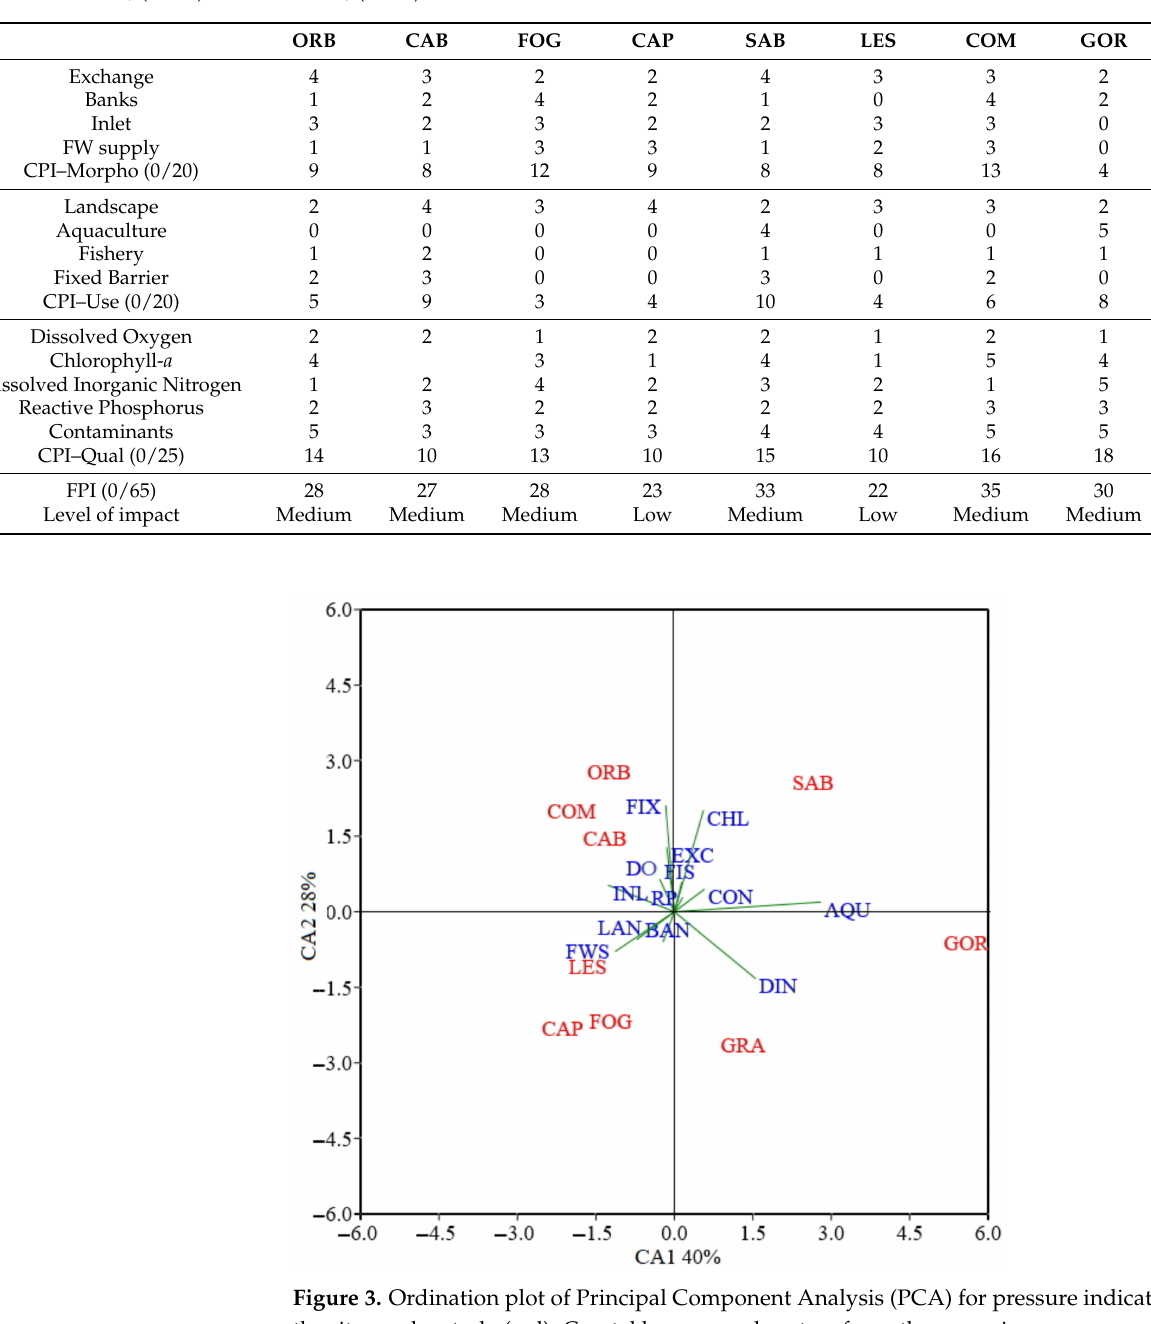
Table 3. Environmental assessment of the lagoons under study. Scores of the single pressure indicators, and the Category Pressure Indices (CPIs) with the Final Pressure Index (FPI) of each coastal lagoon are reported, compared with the maximum achievable values. (ORB) Orbetello, (CAB) Cabras, (FOG) Fogliano, (CAP) Caprolace, (SAB) Sabaudia, (LES) Lesina, (COM) Comacchio, (GOR) Sacca di Goro, (GRA) Grado Marano.